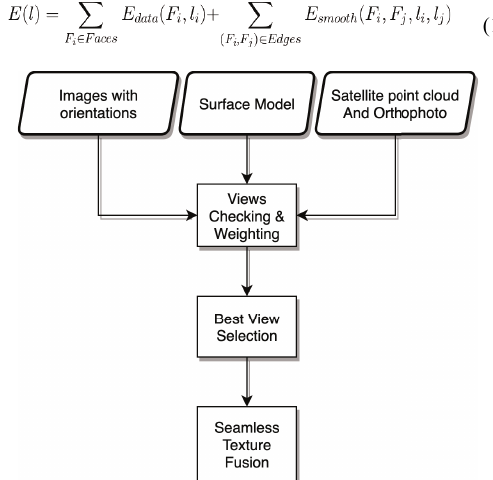
Figure 9. Our pipeline of multi-source texture mapping